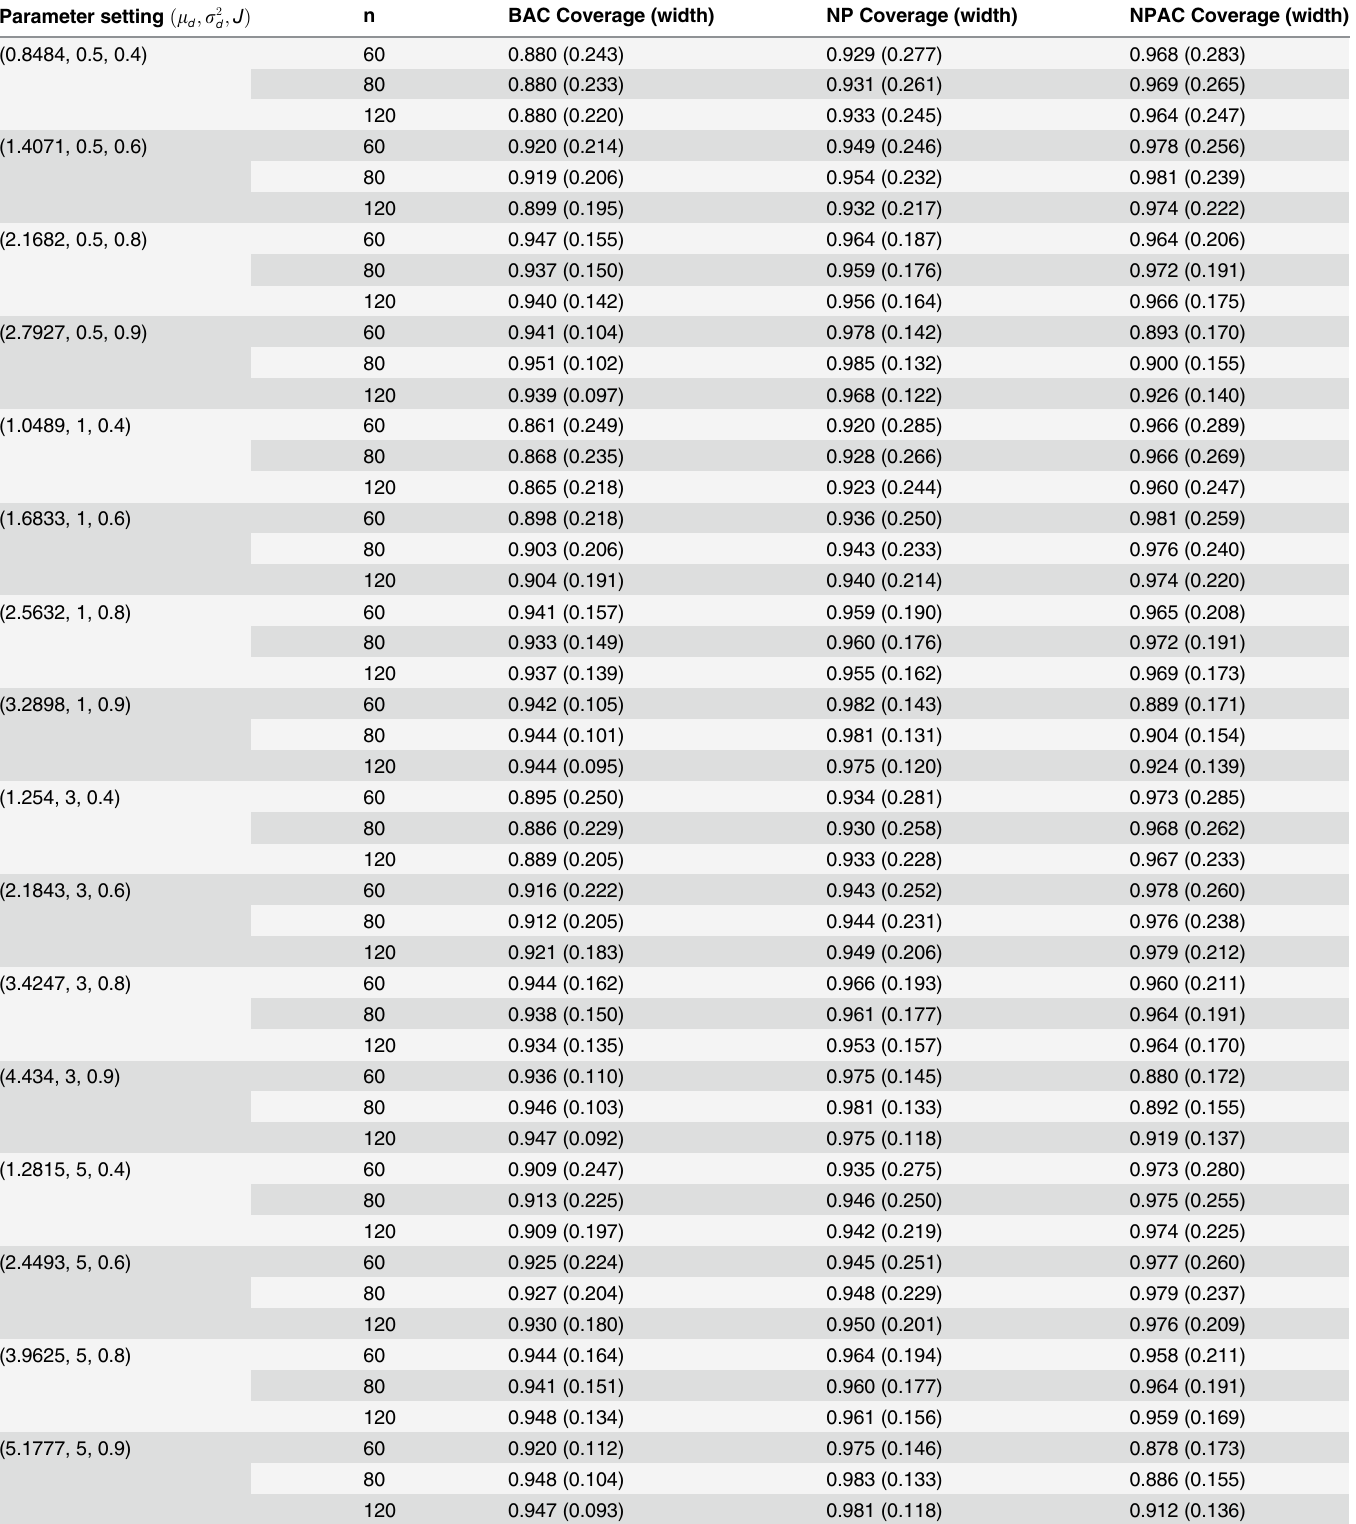
Table 4. Normal distributions: coverage probabilities and average widths when m = 80 in the non-diseased group at the 95% nominal